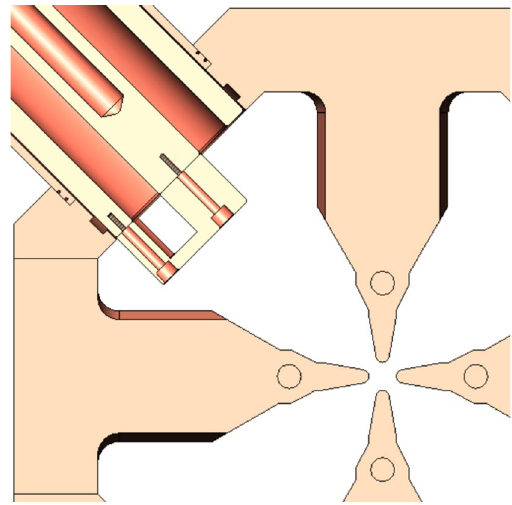
FIG. 17. A cross section of the RFQ at the position of the power coupler.